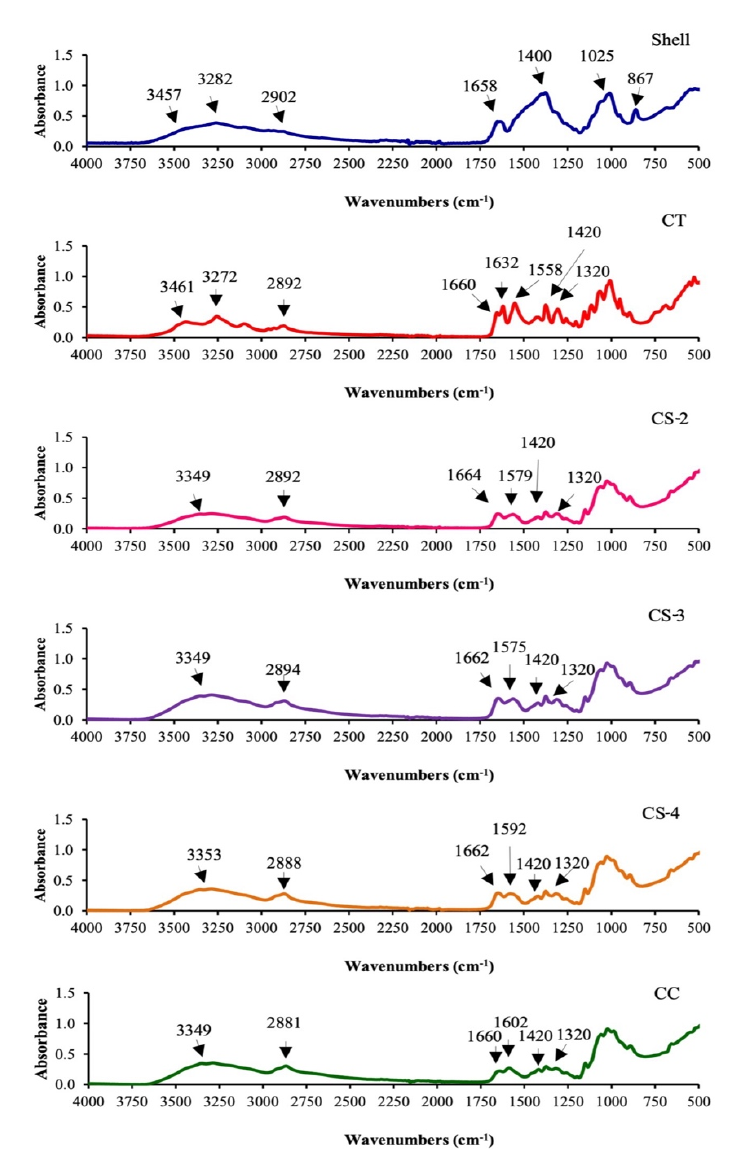
Figure 1. FTIR spectra of mantis shrimp ( Oratosquilla nepa ) shell, CT and CS with different deacety- lation times (2 − 4 h). CT, chitin; CS − 2, CS − 3 and CS − 4, chitosan prepared from chitin with deacetyla- tion times of 2, 3 and 4 h, respectively; CC, commercial CS.